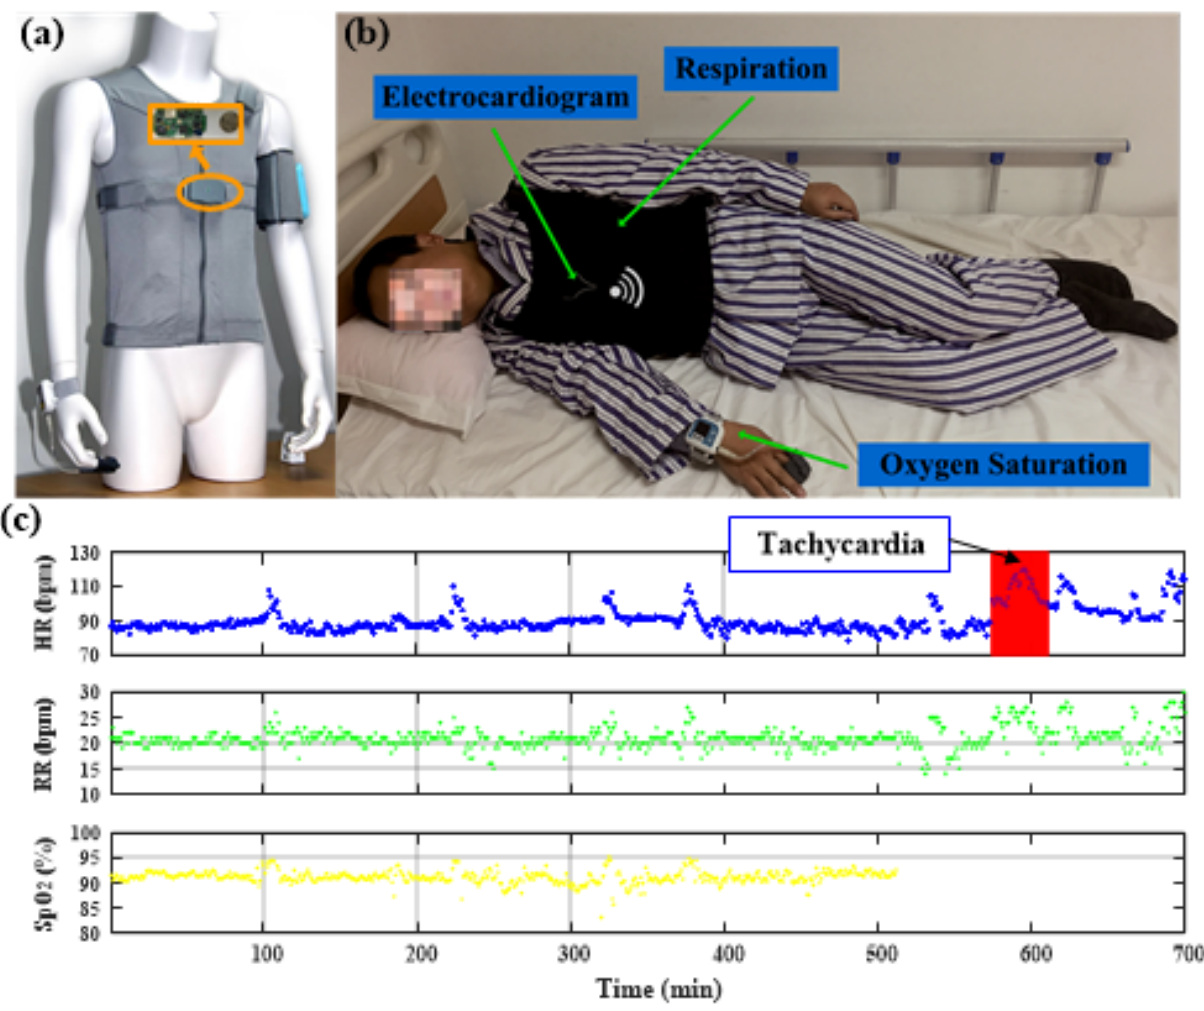
Figure 6. Continuous monitoring using (a) SensEcho system with (b) example of a patient with sensors attached, and (c) sample data. HR: heart rate; RR: respiratory rate; SpO 2 : blood oxygen